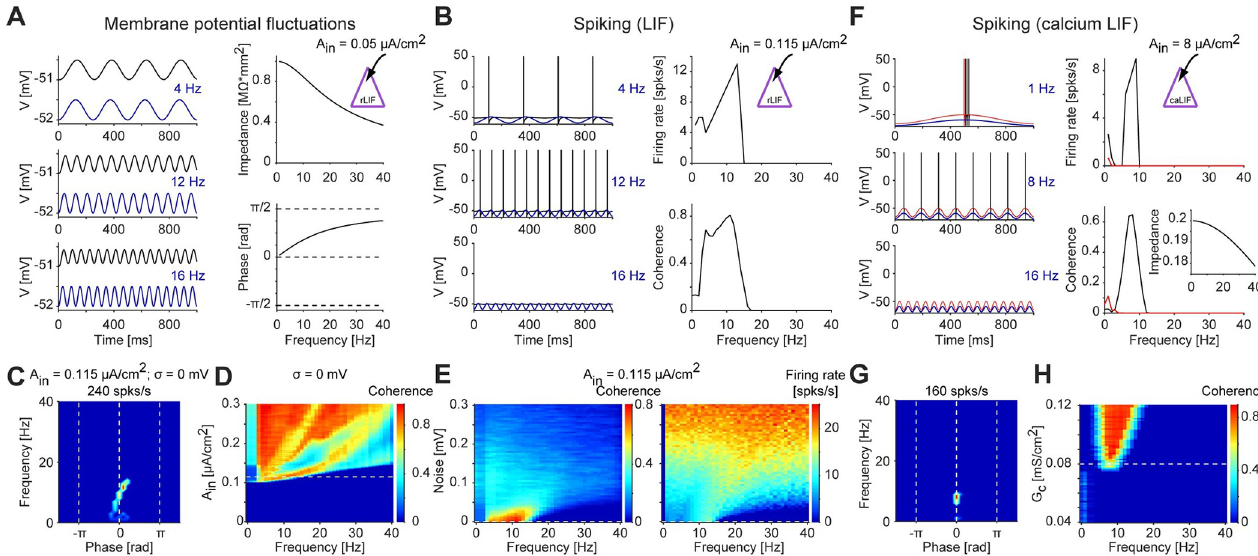
Fig 3. Resonance can be generated directly at the spiking level. ( A ) A leaky integrate and fire (LIF) model neuron was driven by periodic current at various frequencies. Left : Current input (blue, arbitrarily scaled) and membrane potential (black) at three selected frequencies. Top right : Impedance profile shows an LPF response. ( B ) The model neuron of panel A was driven by higher-amplitude periodic currents. Left : Spikes are produced at the peaks of the input cycles. At higher frequencies (e.g., 12 Hz), more cycles occur per unit time than at lower frequencies (4 Hz), corresponding to an HPF (discretization effect). Right : Combined with the subthreshold LPF (panel A ), the “resonant LIF” (rLIF) exhibits spiking resonance. ( C ) Spiking fingerprint of the rLIF model; conventions are the same as in Fig 2C . Spikes are generated at a specific range of frequencies and phases, corresponding to spiking resonance. ( D ) Coherence as a function of input amplitude for the rLIF model; conventions are the same as in Fig 2D . At higher amplitudes, spikes occur at all input frequencies and the narrow-band resonance disappears. ( E ) Coherence ( left ) and firing rate ( right ) as a function of noise level, holding input amplitude fixed ( A . 115 μA/cm 2 ) for the rLIF in = 0 model. When membrane potential variability increases, spikes occur at all input frequencies and the narrow-band resonance disappears. ( F ) A modified LIF neuron was constructed with spike dependent calcium dynamics (“calcium LIF”). The calcium-LIF model neuron has an LPF impedance profile ( bottom right , inset ). However, when driven by periodic current sufficient to generate spikes, the spikes appear at a specific frequency band (around 8 Hz; black traces). Without the calcium conductance, only a low-pass spiking filter remains (red traces). ( G ) Spiking fingerprint of the calcium-LIF model; conventions are the same as in Fig 2C . ( H ) Sensitivity analysis of the calcium-LIF to the calcium conductance G c . The width of the resonant frequency band increases with G c